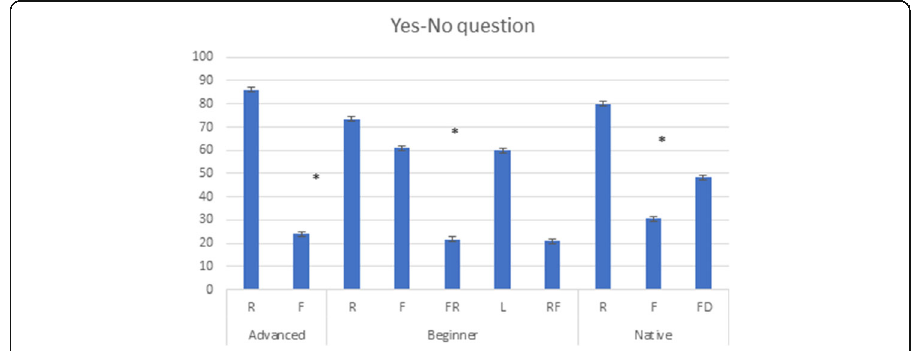
Fig. 2 Mean proportion of final tunes of Yes-No questions by speaker groups. Y-axis: mean percentage. The symbol * means significant at p <